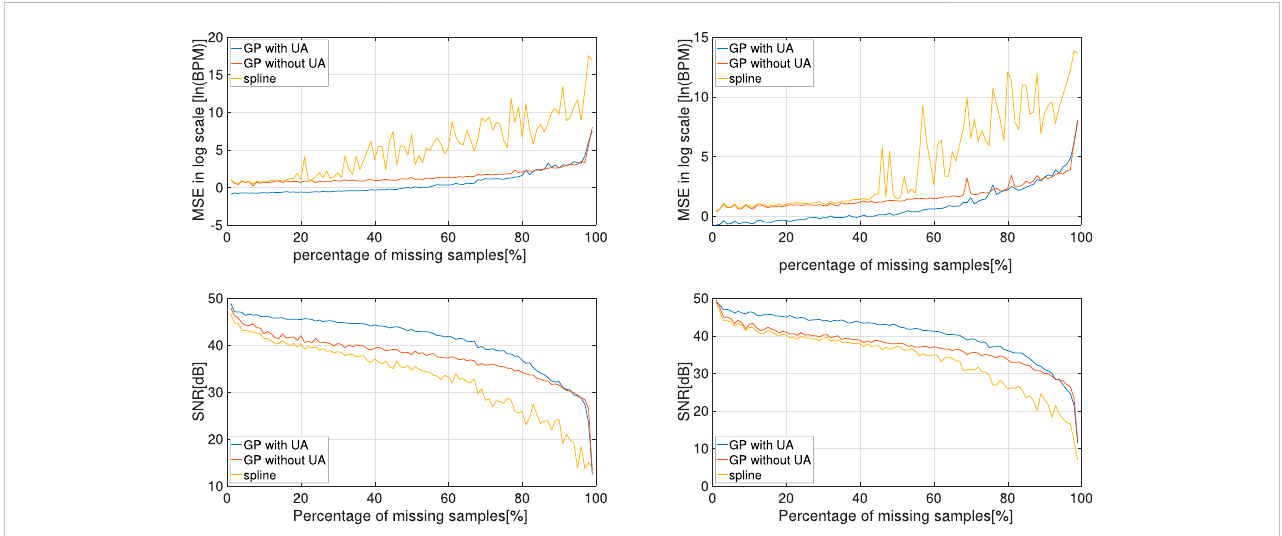
FIGURE 7 ExperimentalresultsofestimatingrandommissingsamplesinFHR:Theexperimentresultsforthe fi rstCTGsegment(left),andtheexperimentresultsfor the second CTG segment (right). The MSE (upper plot, in logarithmic scale) and SNR (bottom plot) of each method under different percentages of missing samples are presented, averaged over 100